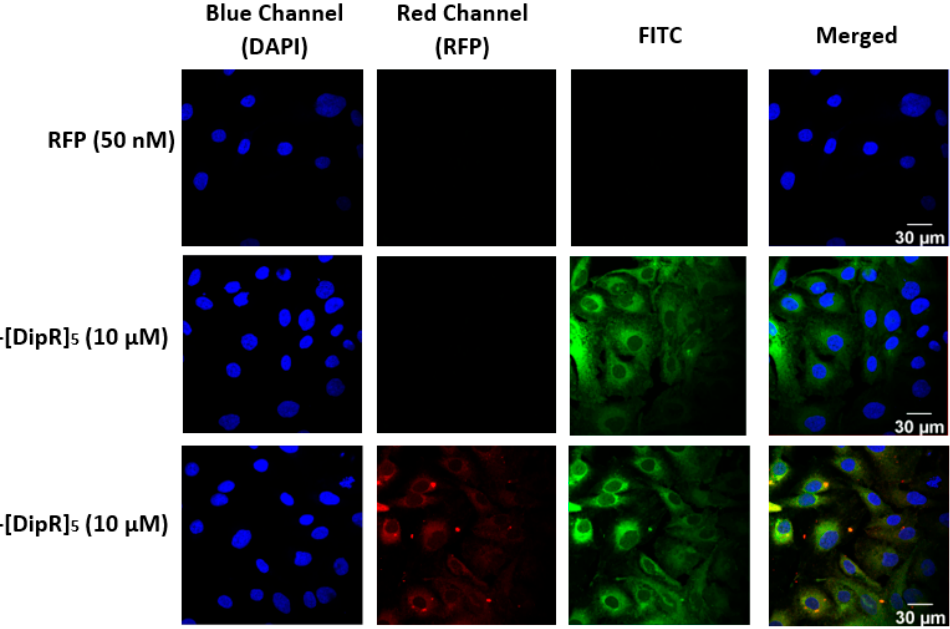
Figure 15. Confocal microscopy images of SK-OV-3 cells incubated with the F ′ -[DipR] 5 or RFP-F ′ - [DipR] 5 mixture at a peptide concentration (10 µ M) and RFP at (50 nM) for 3 h. The red and blue channels visualize RFP and DAPI (used to stain the nucleus), respectively.